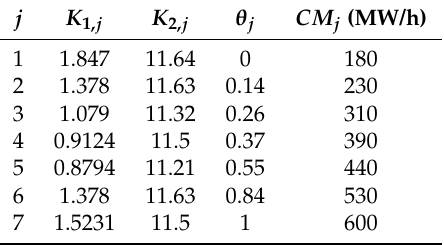
Table 5. Customer cost function coefficients, customer type, and daily customer energy